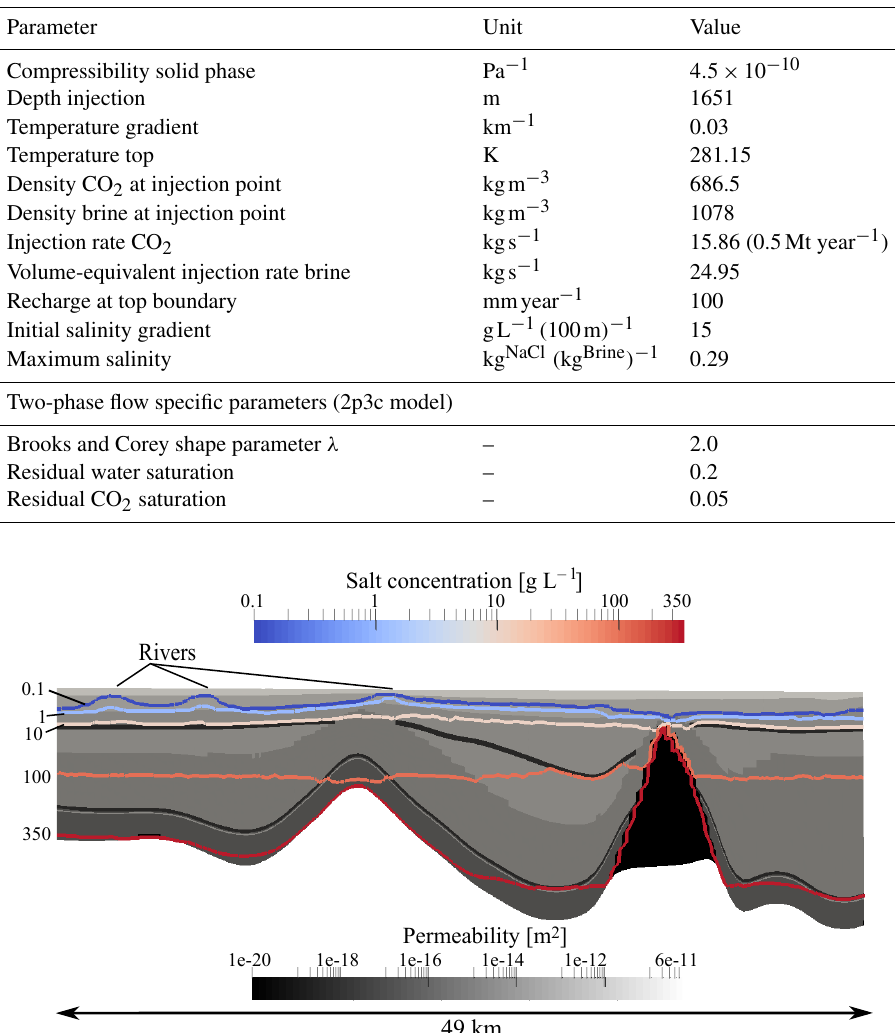
Figure 8. Scenario study 1: initial salt distribution. Salt distribution for the medium (reference) case after a 300000-year initialization run along the cross section AB shown in Fig. 7b) (vertical exaggeration is 4 : 1). Five concentration isolines are shown which correspond to the entries in the legend (0.1, 1, 10, 100, and 300). The permeability of the different layers is also shown. Please note the logarithmic scale of concentration and